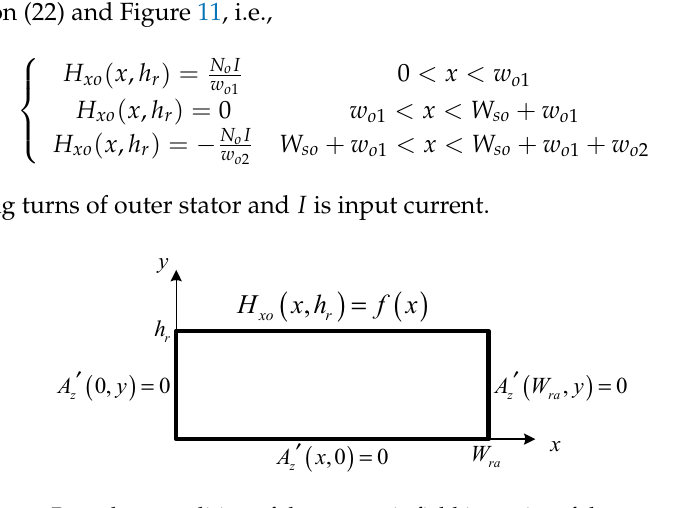
Figure 10. Boundary condition of the magnetic field intensity of the outer stator.